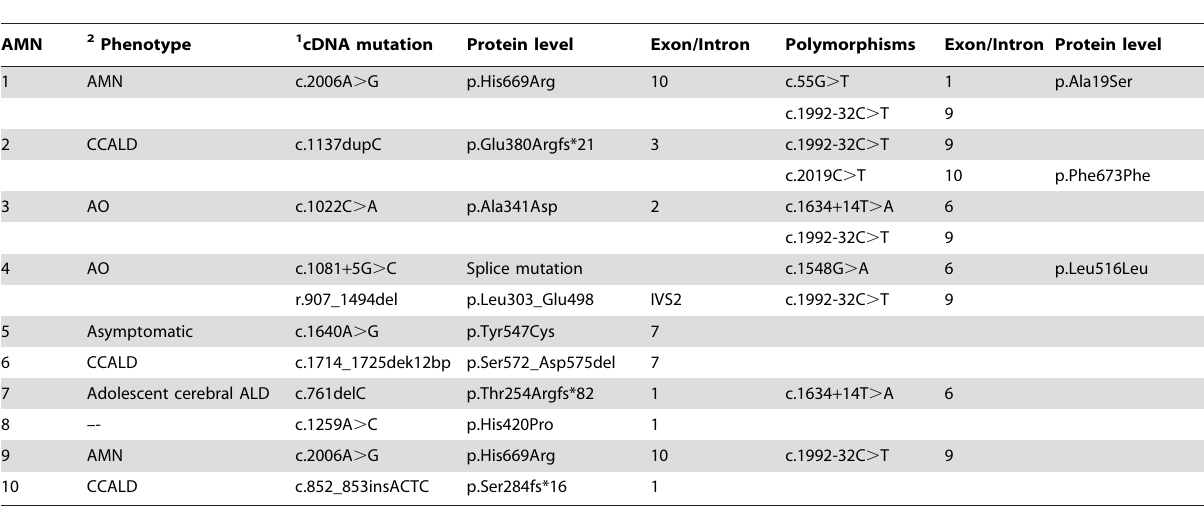
Table 1. Molecular analysis of Argentinean patients with X-linked adrenoleukodystrophy.